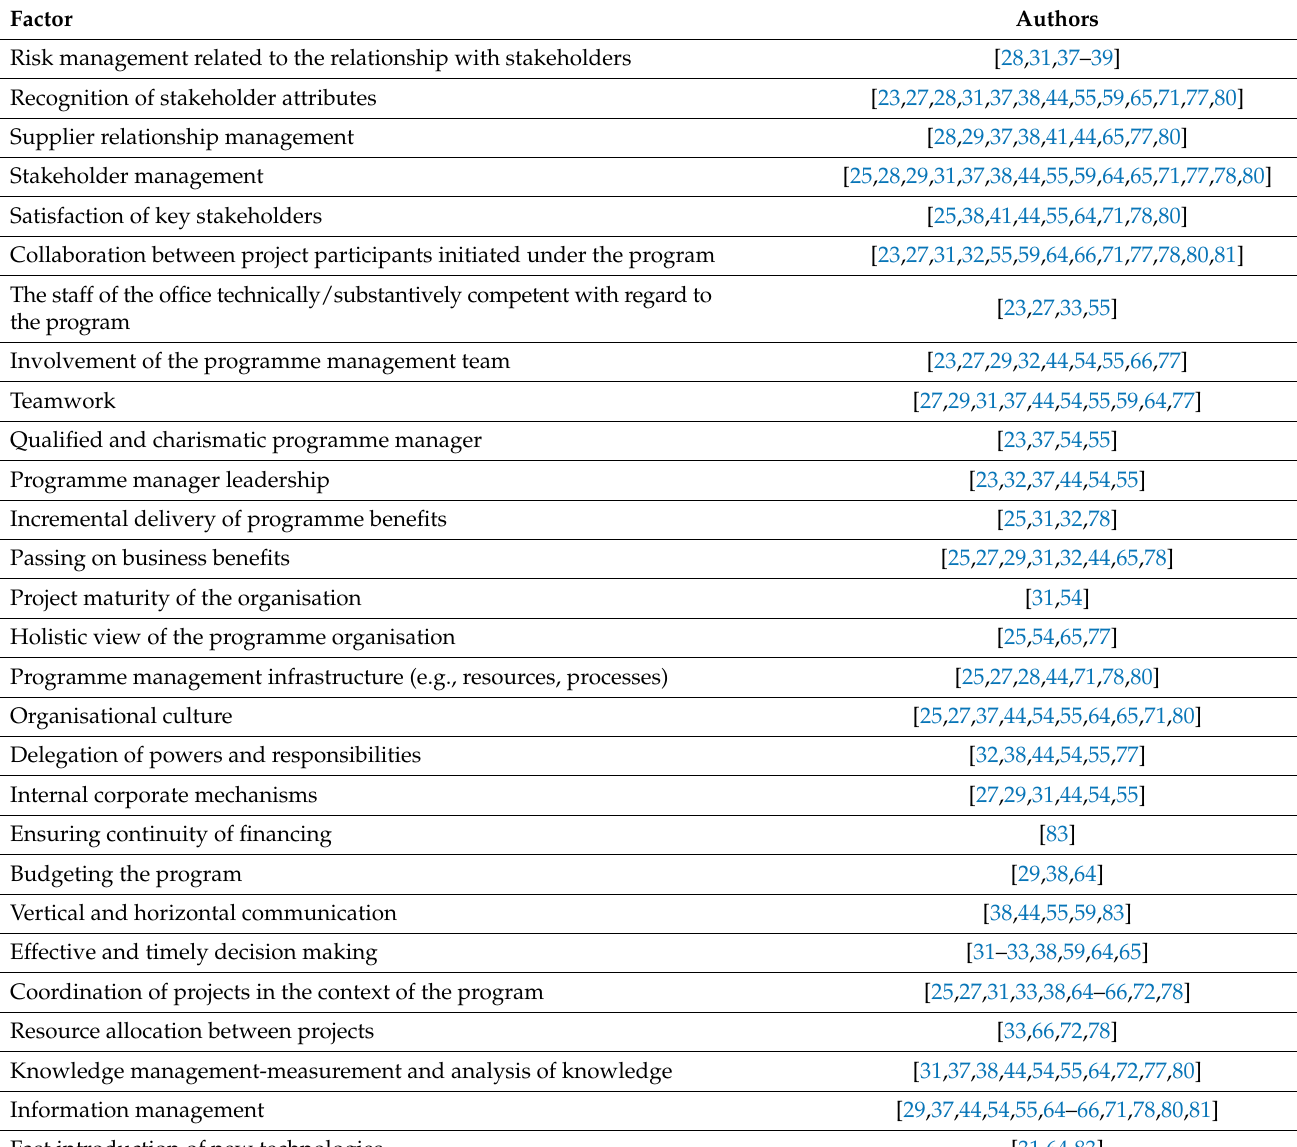
Table 1. Common factors for the success of open innovation and programme